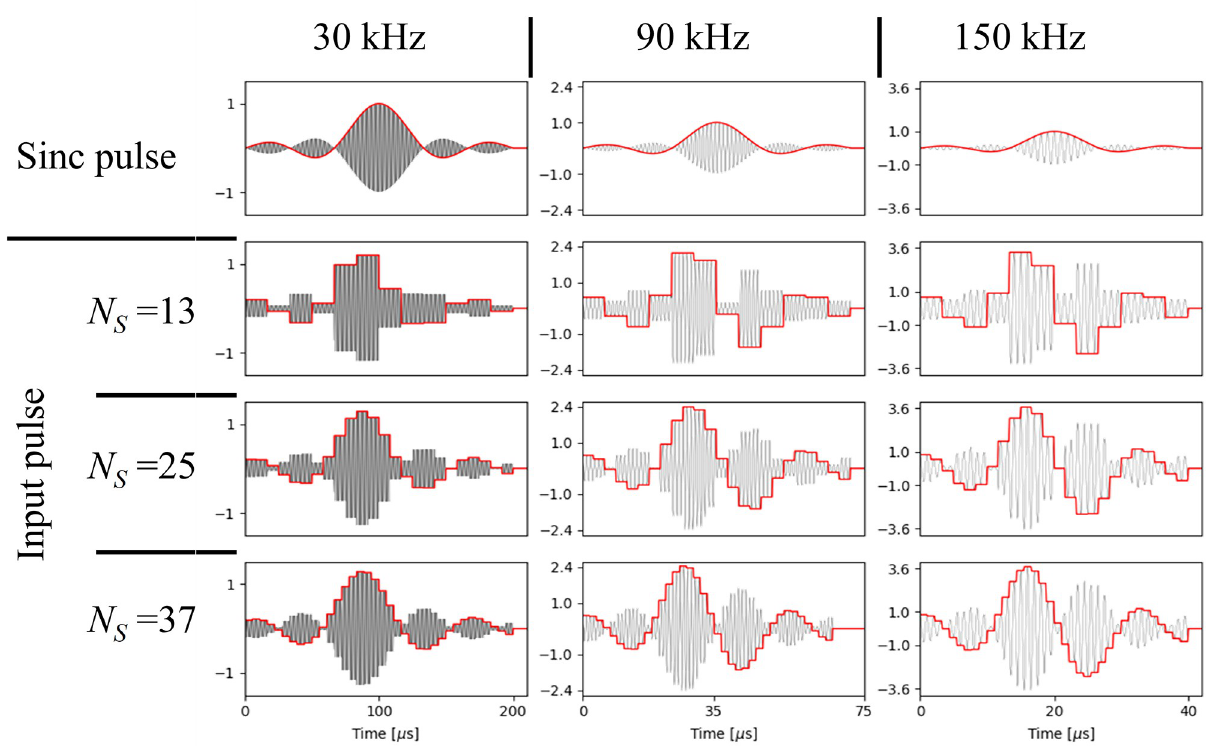
Fig 8. Sinc pulses (top row) and calculated input pulses for compensation calculated with different N S (13 (second row), 25 (third row), and 37 (bottom row)) for different bandwidth (30 kHz (left column), 90 kHz (middle column), and 150 kHz (right column)).